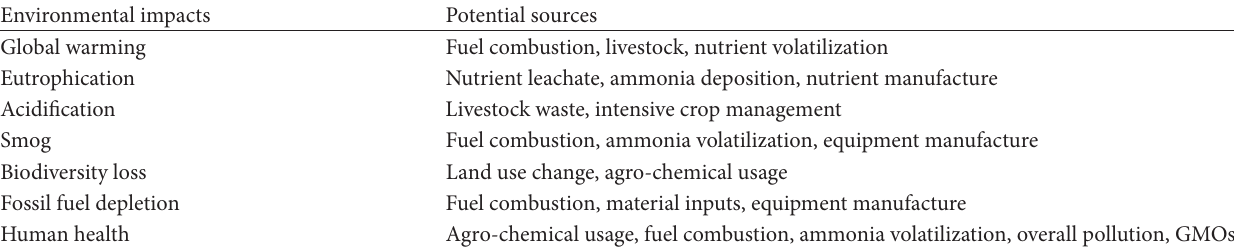
Table 4: Selected environmental impacts associated with